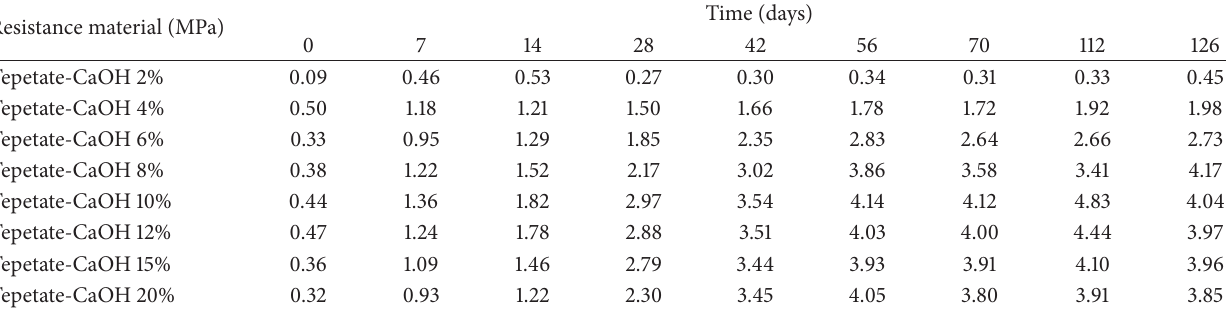
Table 2: Resistance of sustainable-tepetate composite in